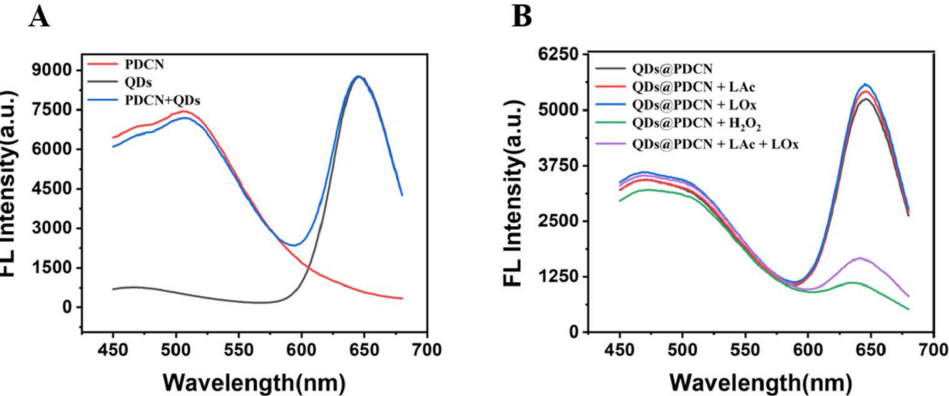
Figure 2. Feasibility test of lactate detection with Alg@PDCN@QDs-LOx MSs. ( A ) Fluorescence spectra of PDCN, QDs, and PDCN + QDs. ( B ) Fluorescence spectra of the CdTe QDs and PDCN mixed solution with tris solution, LOx, LAc, H 2 O 2 , and LAc + LOx. LAc: 1 mM, H 2 O 2 : 1 mM, LOx: 0.06 U/mL.